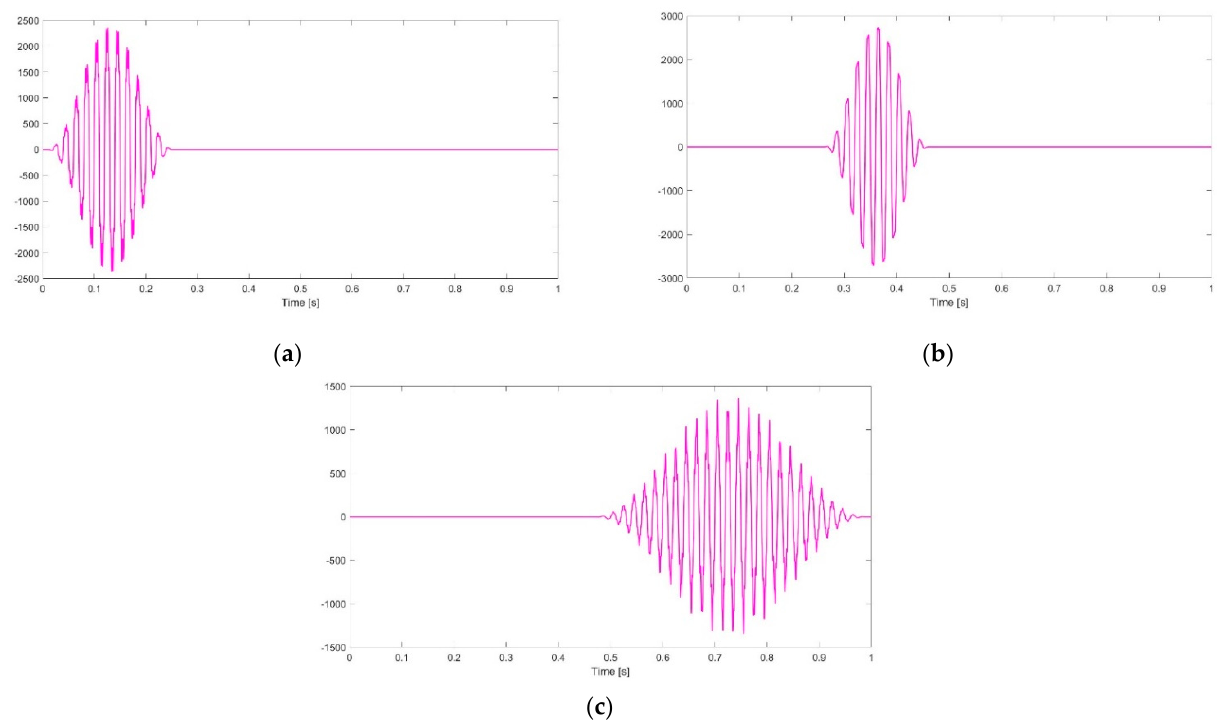
Figure 4. ( a ) First quasi-steady-state interval enhanced with a Hanning window, ( b ) second interval enhanced with a Hanning window, ( c ) last interval enhanced with a Hanning window.